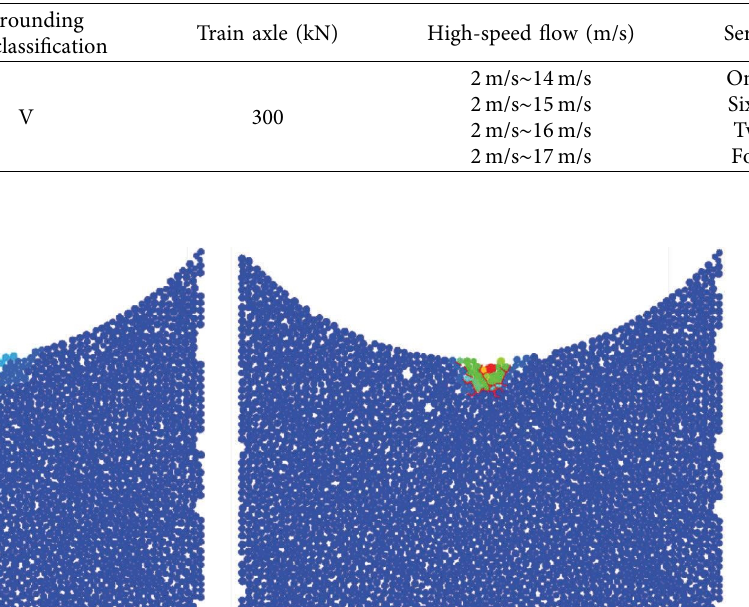
Table 4: Calculation conditions of a discrete